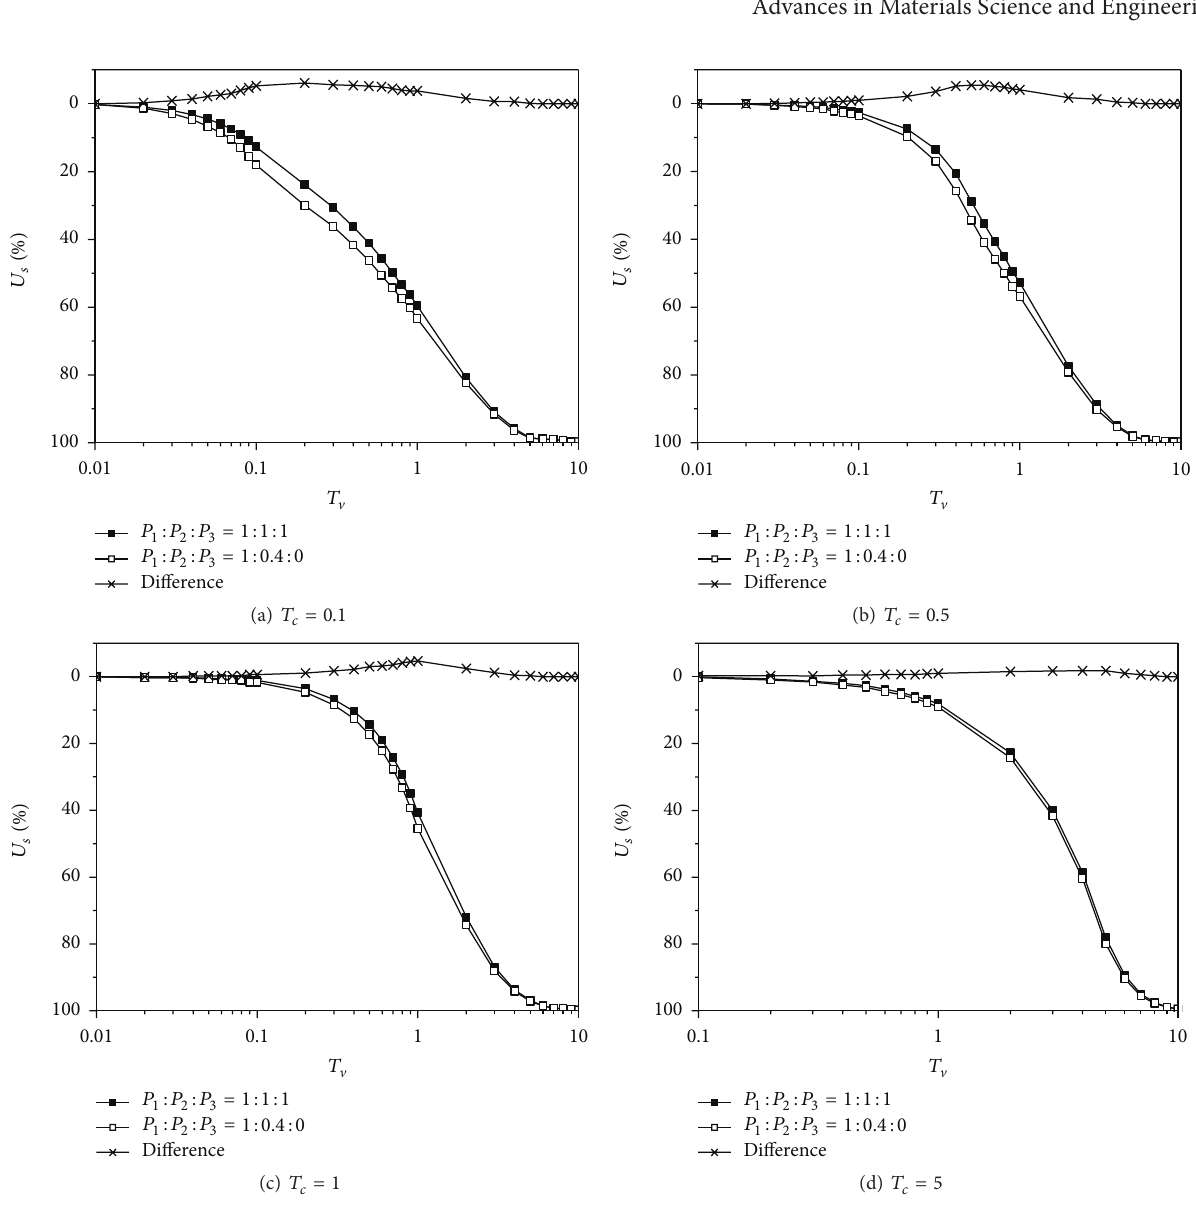
Figure 9: Consolidation curves with a double-drained